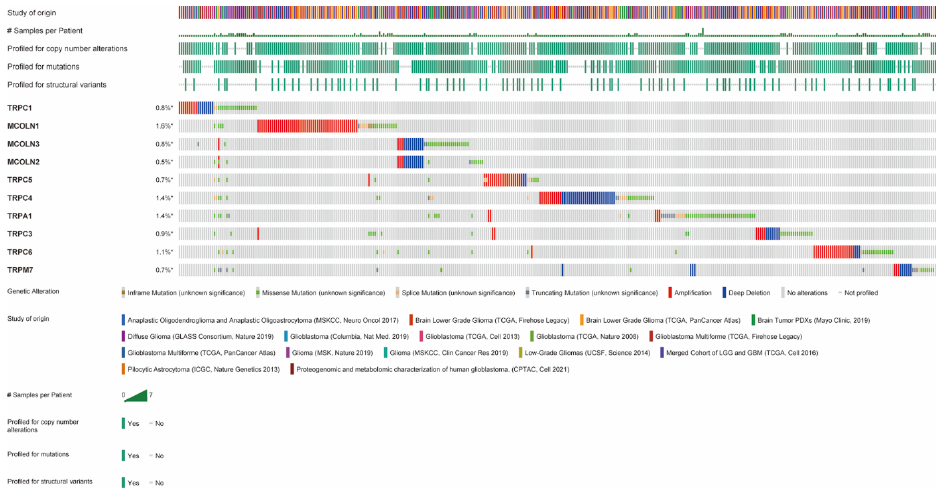
Figure 3. Amplification, deletion, and mutation of hub genes of TRPs family in glioma. Genetic variations in hub genes of the TRPs family were detected using the cBioportal database.